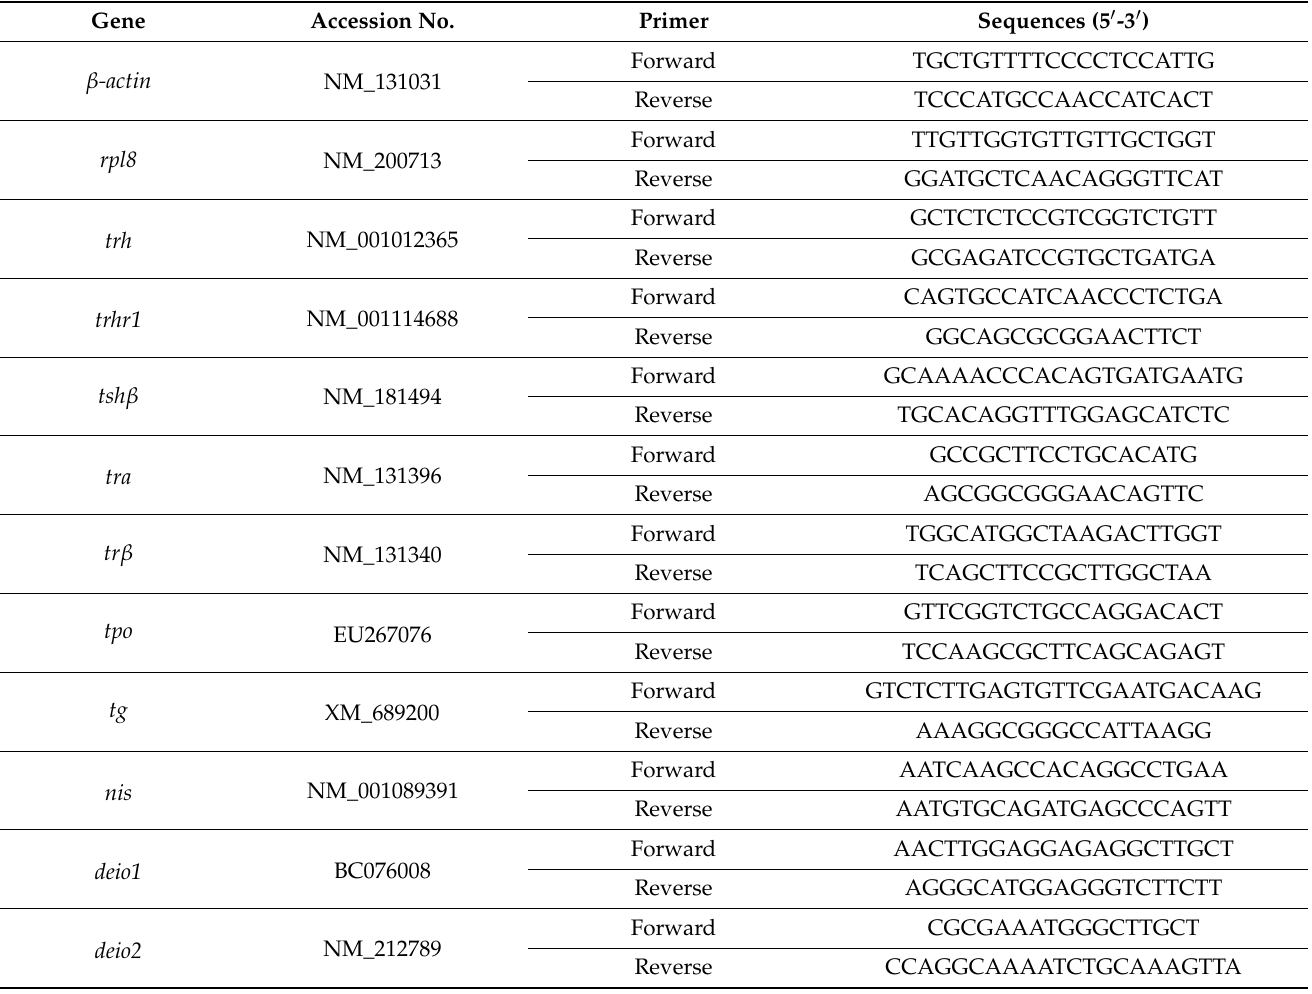
Table 1. Sequences of primers for the gene